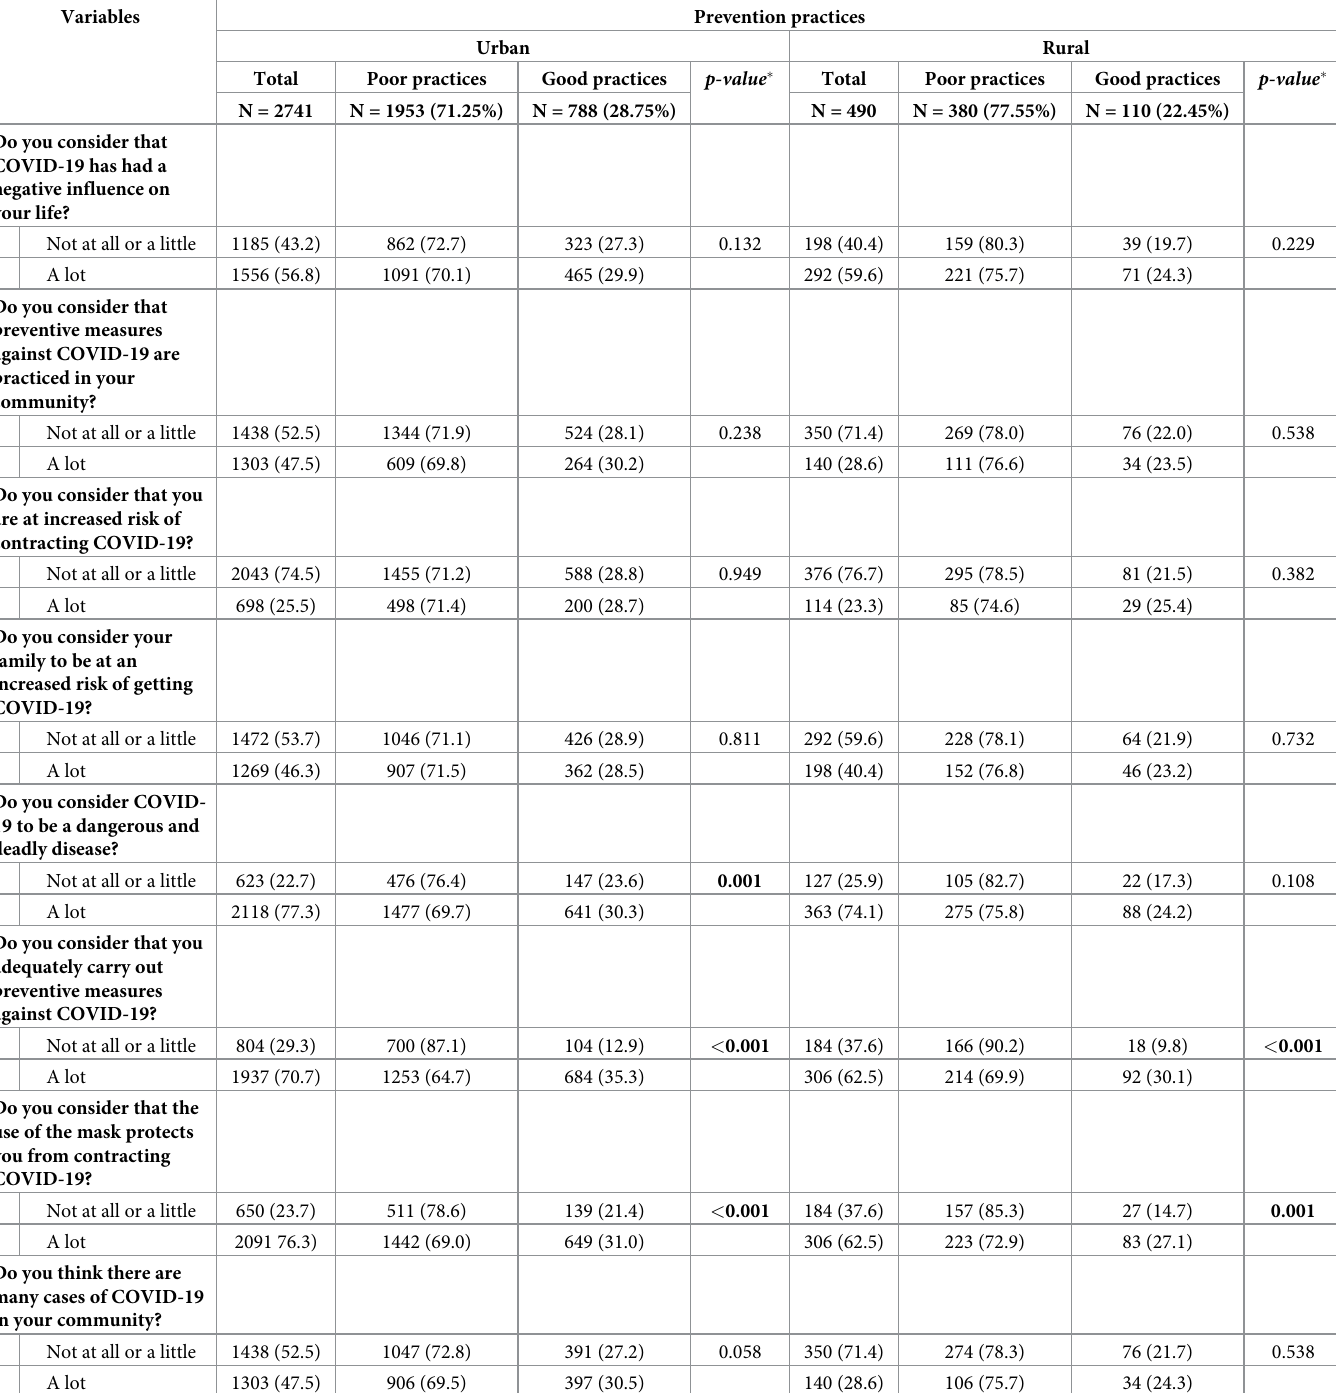
Table 3. Perceptions on COVID-19 of study participants, according to rurality strata and prevention practices (N =